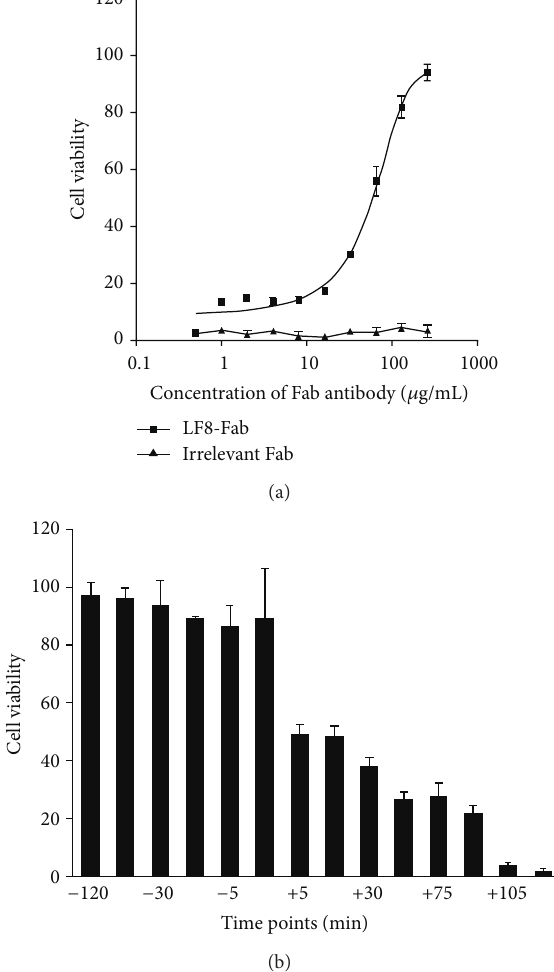
Figure 5: In vitro protection of J774A.1 cells against LeTx challenge. (a) In vitro neutralization assay showed that LF8-Fab could protect cells against LeTx in a dose-dependent manner, with an EC 50 of 85 𝜇 g/mL according to calculation of SPSS statistical software. The percentage of viability was demonstrated by GraphPad Prism software. (b) In vitro LeTx challenge study to test neutralization effect of LF8-Fab before or after LeTx exposure of J774A.1 cells at different time points. Minus ( − ) means LF8-Fab prior to LeTx, while plus (+) means LeTx prior to LF8-Fab. LF8-Fab could completely neutralize LeTx and protect cells as long as the treatment was prior to LeTx addition. As for the converse situation, protection effect declined in a time-dependent